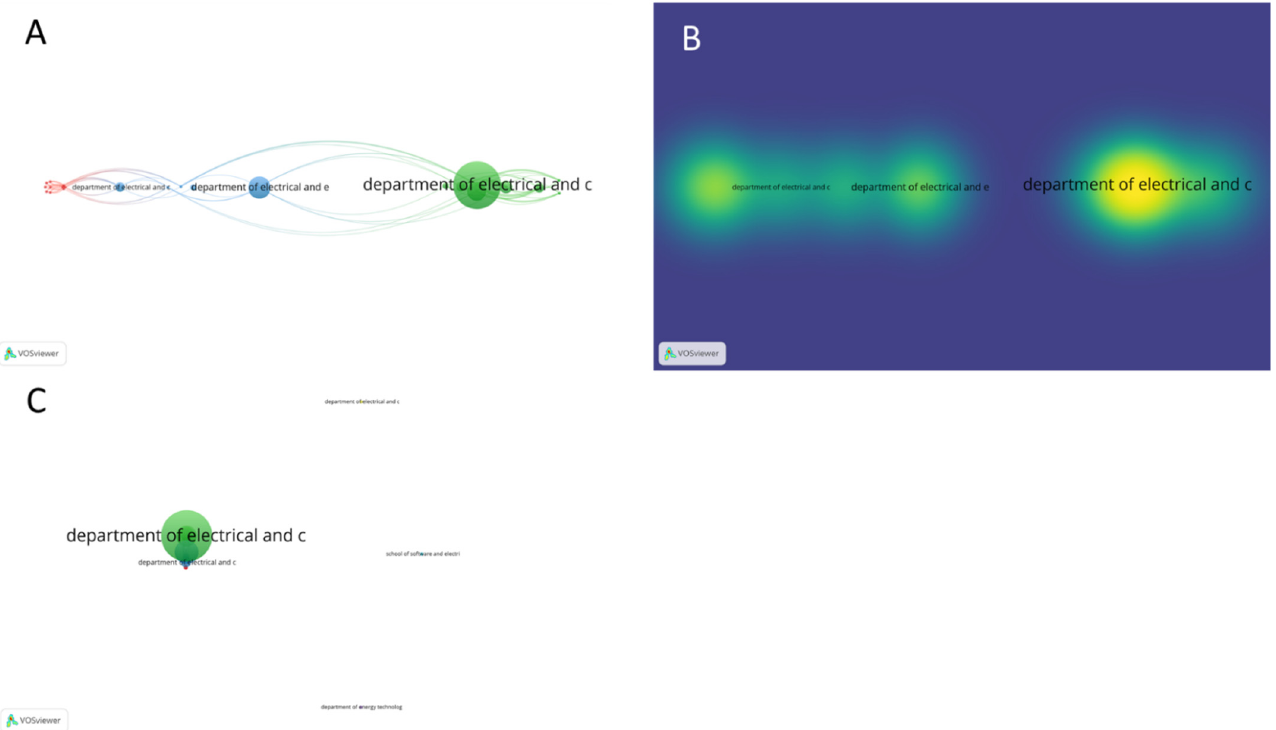
Figure 13. Citation network for research institutions. Network visualization ( A ) and density map ( B ) show 23 out of 2292 organizations that met the threshold of one document and 300 citations per organization. There were three clusters and 75 links. Network map ( C ) showed unconnected organizations surrounding a central cluster of connected organizations.